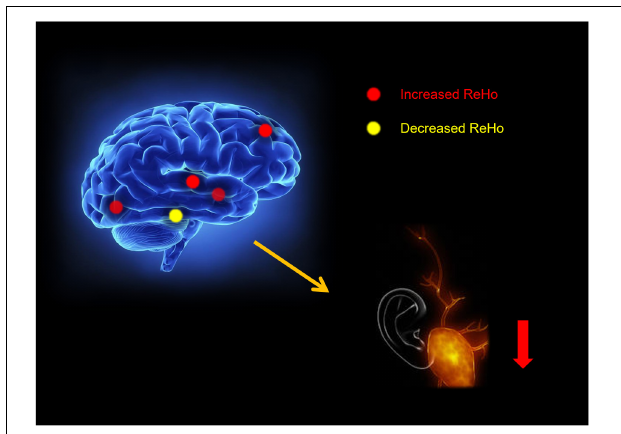
FIGURE 6 | The hearing loss results of brain activity.